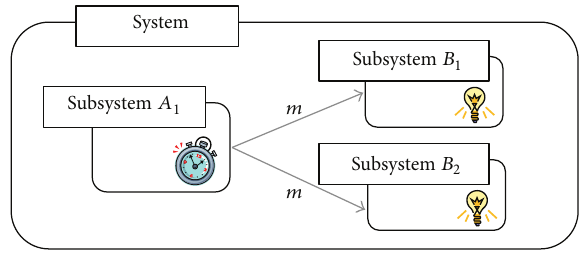
Figure 3: An example embedded